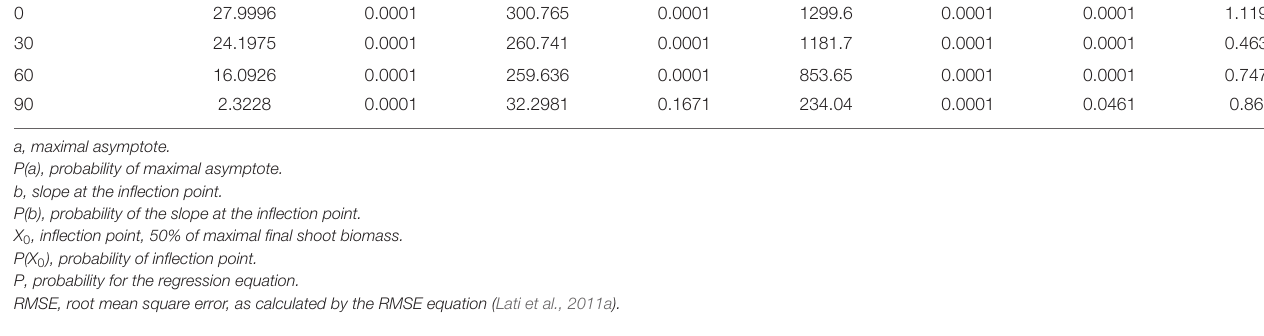
( Figure 5C ). The highest effect of the radiation level on plant biomass accumulation was recorded for the 90% shading